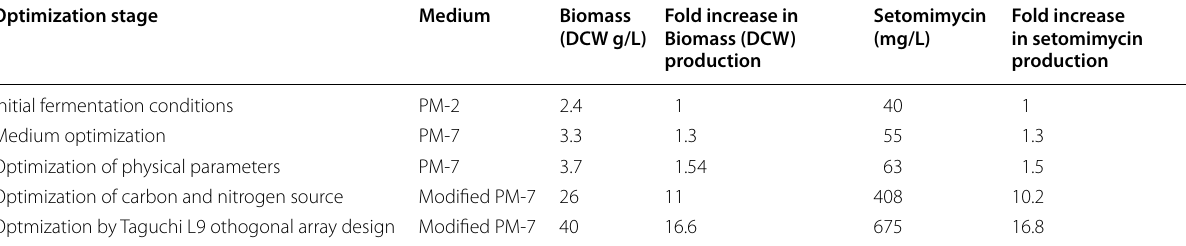
Table 10 Summary of optimization studies for biomass (DCW) and setomimycin production by Streptomyces sp. RA-WS2 Optimization